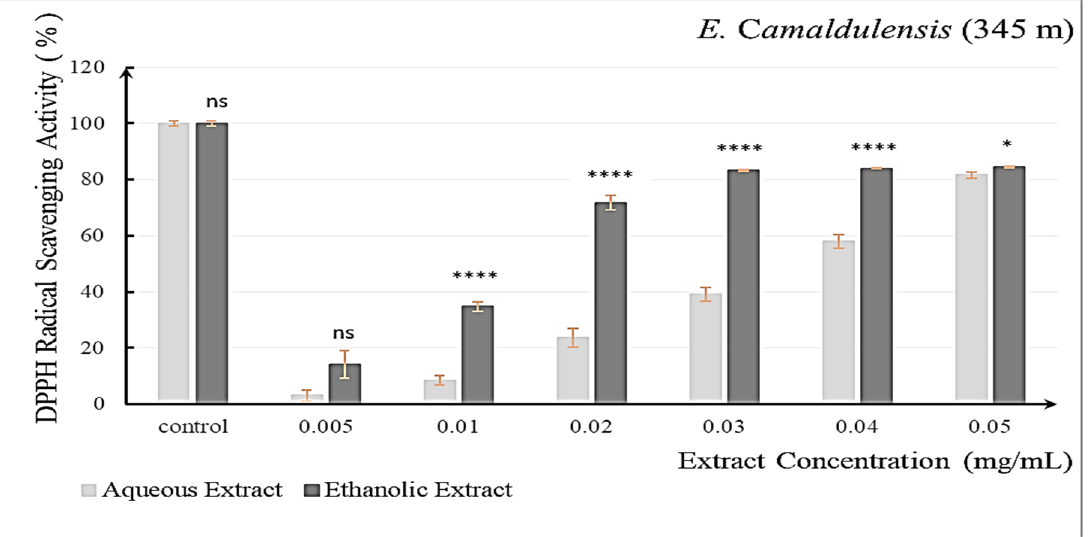
Figure 1. Radical scavenging activity of the ethanolic and aqueous extracts of E. camaldulensis (345 m). Peak values are represented as mean +/ − SD. Statistical analysis: Unpaired t test or Mann–Whitney test. * p < 0.05; **** p < 0.0001. ns refers to non-significant results. Table 6. DPPH absorbance of the different concentrations of ethanolic and aqueous extracts.